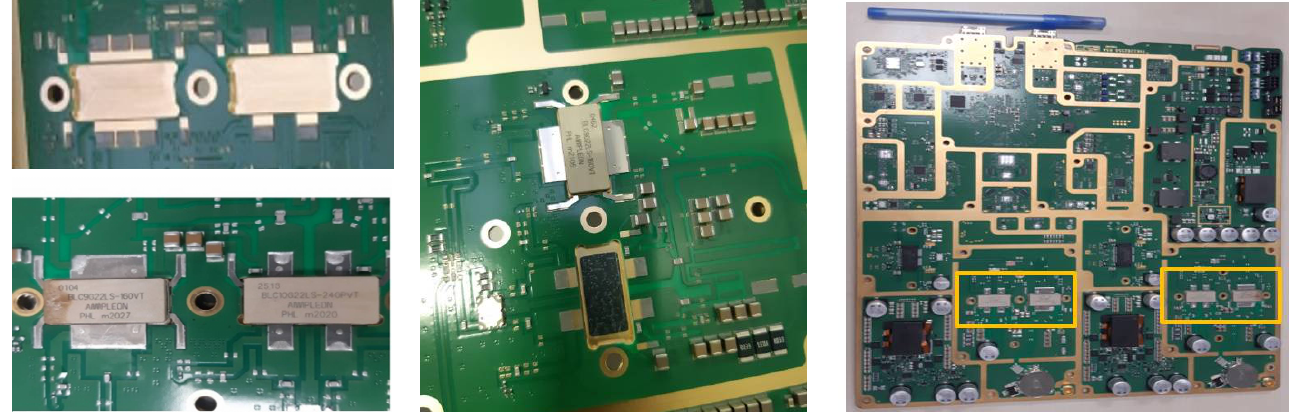
Figure 2. Selected parts of the PCB on which the investigated RF power transistors are mounted.